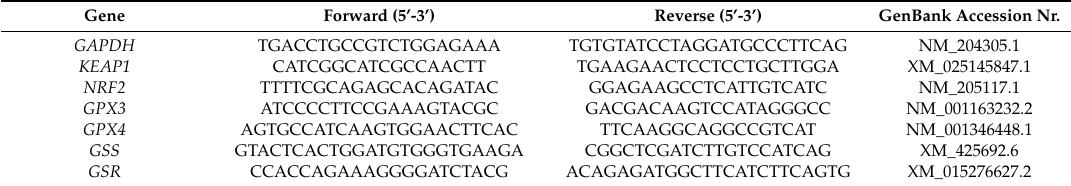
Table 2. Primers of target ( GPX4 , GPX3 , GSS , GSR , NRF2 , KEAP1 ) and endogenous control ( GAPDH ) genes.